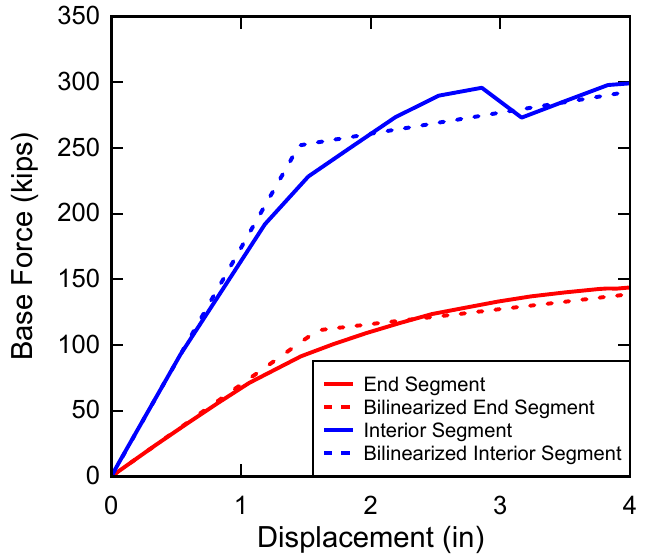
Figure 7. Force–displacement relationships and bilinearization for interior and end segments from isolated parapet model. Table 2. Comparison of Yield Line and Pushover Analysis of Fixed Base Parapet Model.